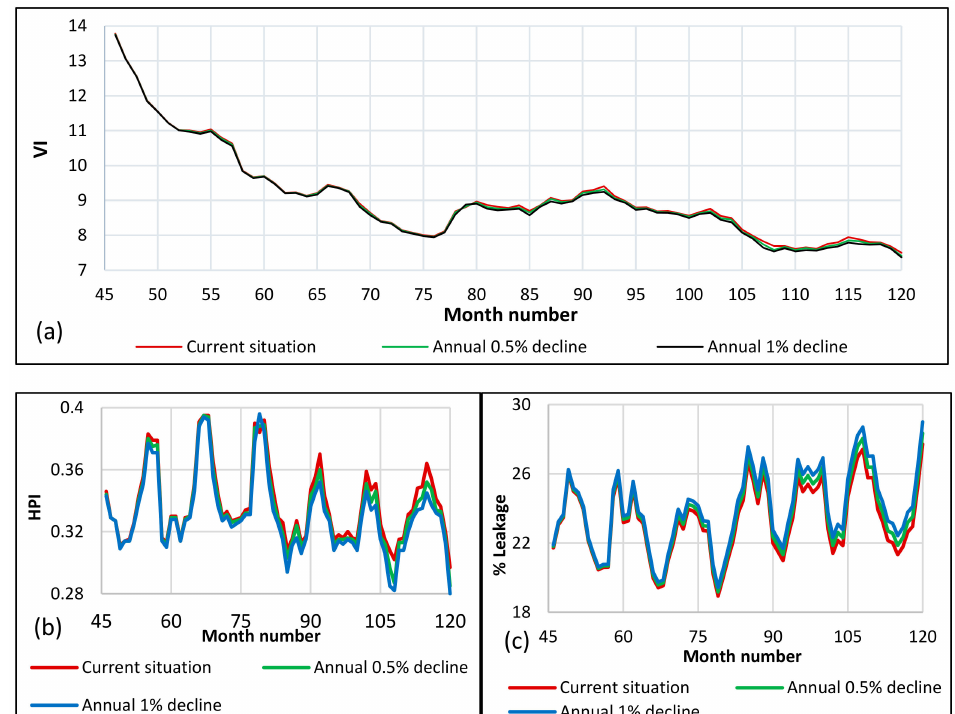
Figure 12. E ff ects of per capita water demand reduction by the annual rate of 0.5% and 1% on: ( a ) VI; ( b ) HPI; ( c )